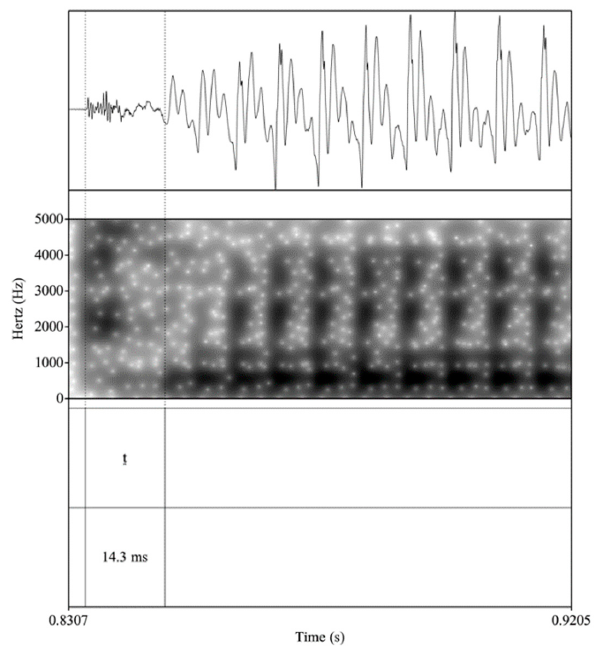
Figure 1. Spanish production of the word-initial /t/ in total.